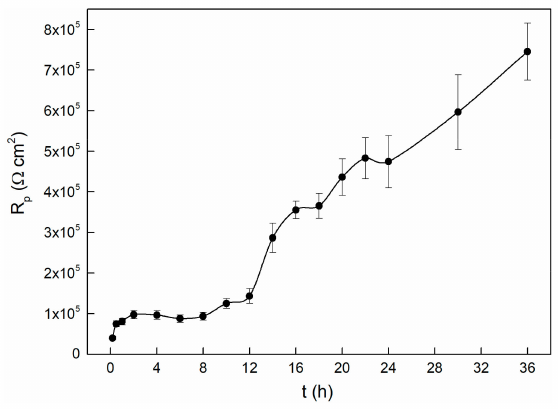
Figure 3. Polarization resistance changes with time for TC11 alloy in 0.01 M Na 2 SO 4 solution.